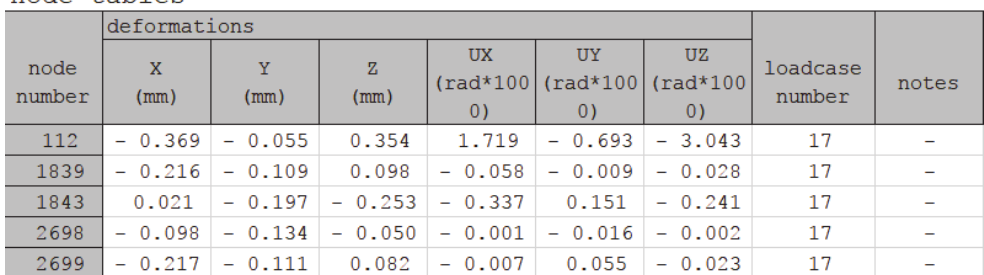
Fig. 2: Example of Data received from main